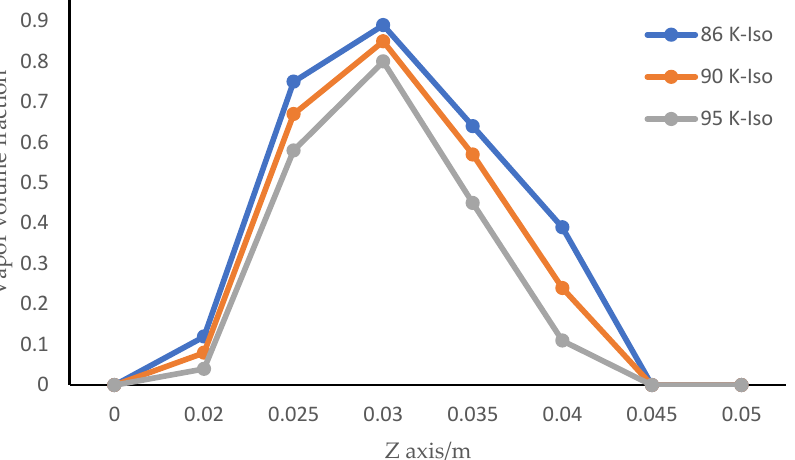
Figure 14. Volume fraction distribution of liquid oxygen in the inducer in the Zwart isothermal cavitation model.